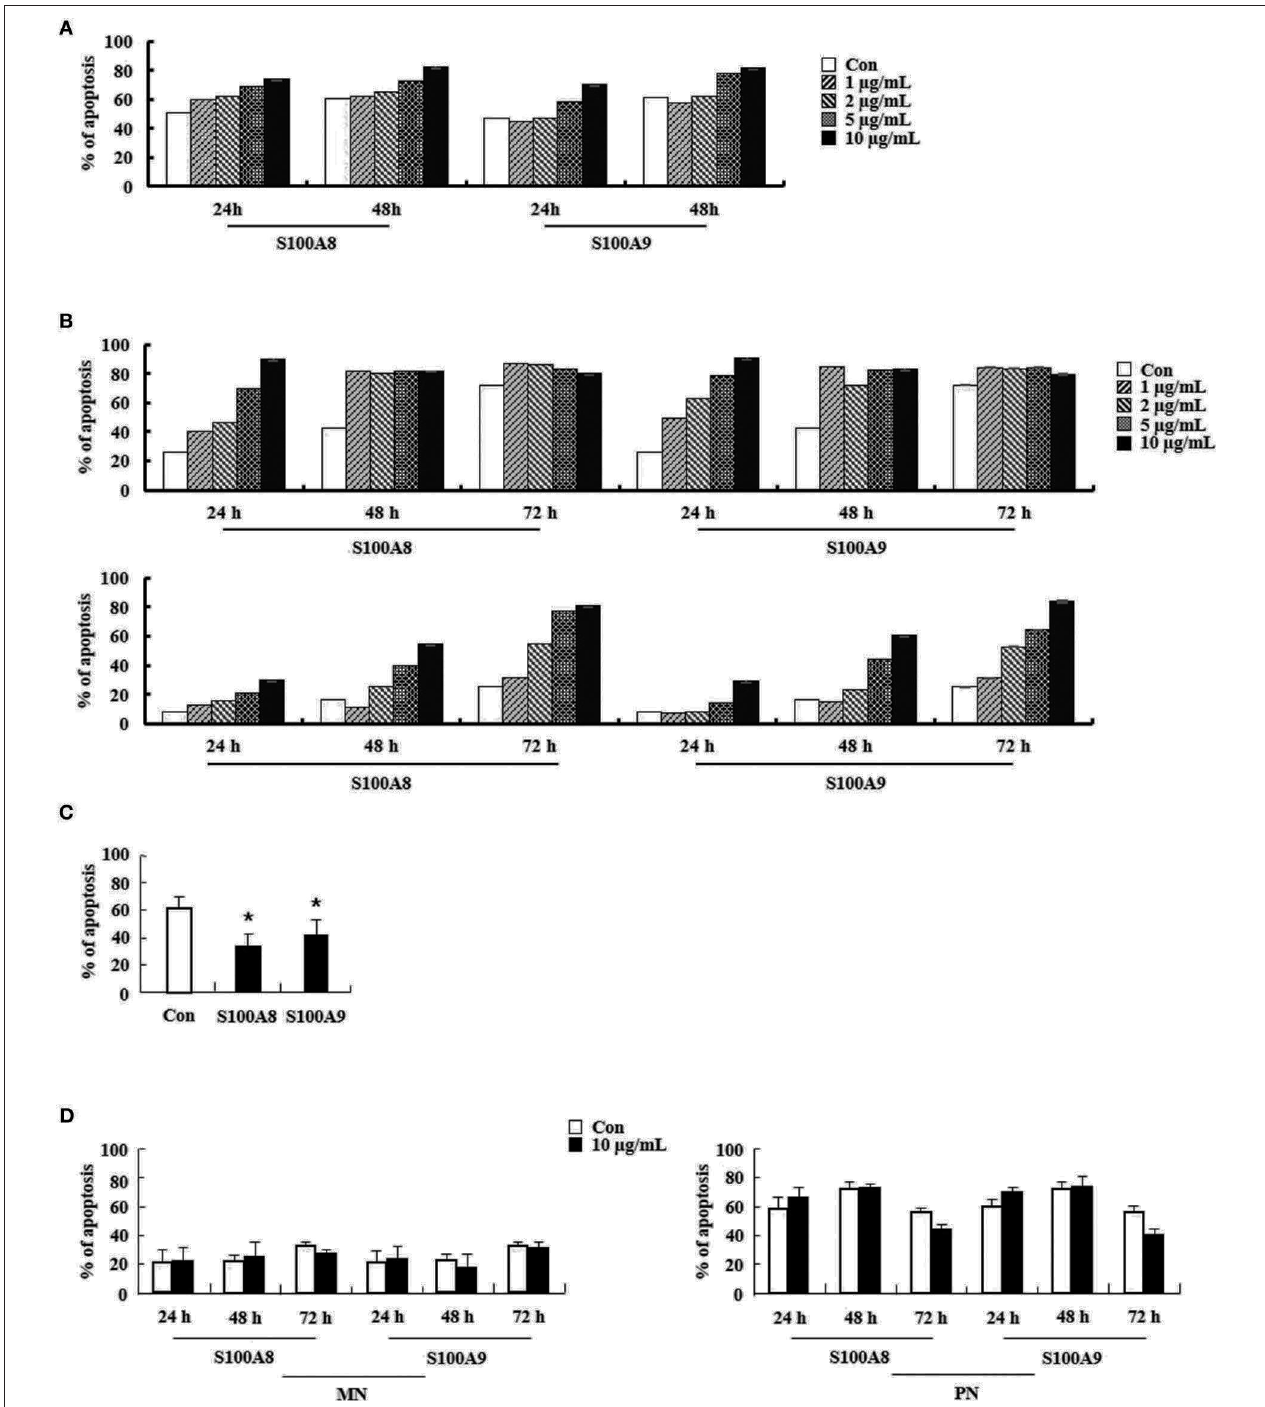
FIGURE 6 | S100A8 and S100A9 elicit apoptosis of eosinophils isolated from CEL and HES patients. (A–D) Eosinophils were isolated from CEL ( n = 1) (A) , HES ( n = 2) (B) , and reactive eosinophilia subjects ( n = 5) (C) , and polymorphonuclear cells and mononuclear cells were separated from AML subjects ( n = 5) (D) . Eosinophils from CEL, HES, and AML were incubated for 24, 48, or 72h, and the cells from reactive eosinopohilia were incubated for 48h with the indicated concentrations of S100A8 and S100A9. Apoptosis was analyzed by measuring the binding of annexin V-FITC and PI. Data are expressed as the means ± SD . * p < 0.05 indicates a significant difference between the control and stimulator-treated